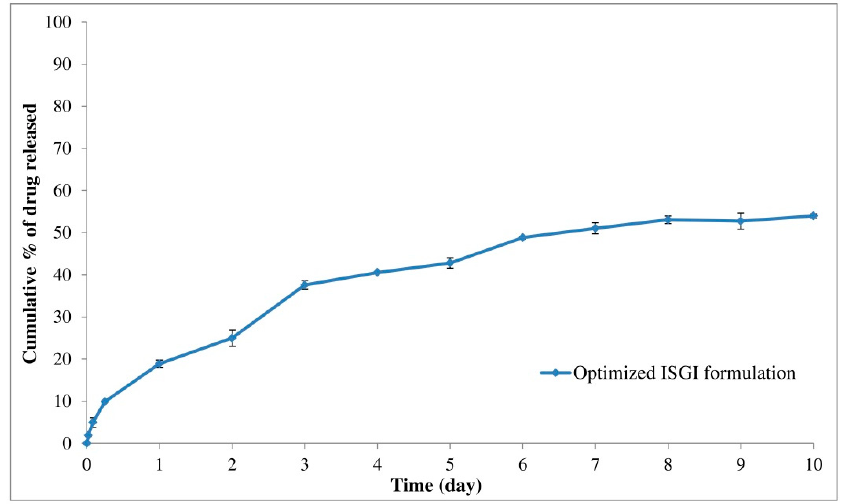
Figure 7. In vitro release of optimized alogliptin-loaded ISGI formulation.